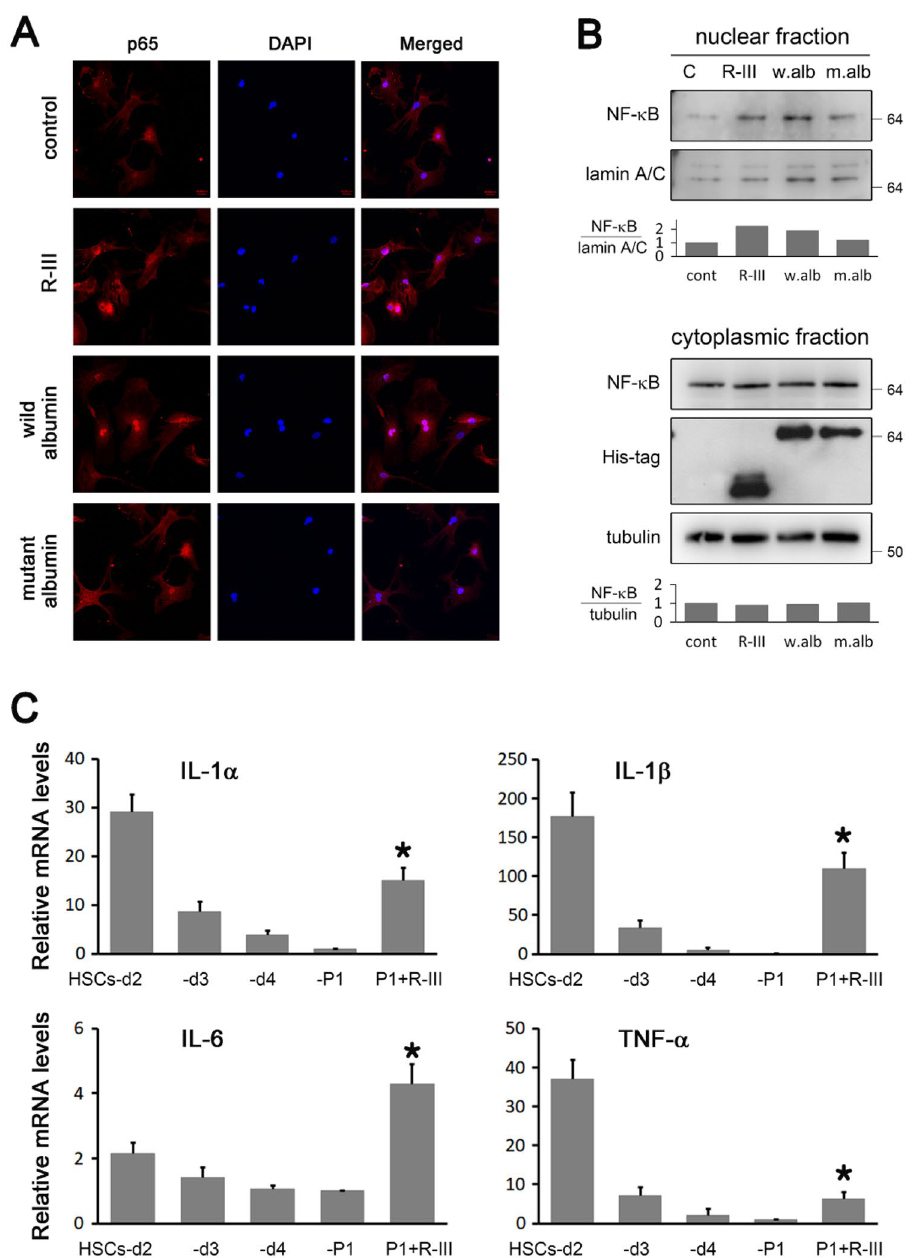
Figure 2. R-III treatment and albumin expression promote the nuclear translocation of NF-κB. ( A , B ) Hepatic stellate cells after passage 1 (HSCs-P1) were treated with HPLC-purified, His-tagged R-III (0.25 μM) or transfected with plasmids encoding His-tagged, wild-type or mutant albumin (R410A, Y411A, K525A) and then analyzed by immunofluorescence using the anti-p65 antibody ( A ). The cell nuclei were stained with DAPI (blue). ( B ) Nuclear and cytoplasmic fractions were prepared from the treated cells and subjected to western blotting using anti-NF-κB antibody. Lamin A/C and α-tubulin were used as internal controls. Bar graph represents the average of two independent experiments. Full-length blots are presented in Supplementary Fig. S4. ( C ) Total RNA was isolated from the HSCs on days 2, 3, and 4 after seeding (different stages of activation), and HSCs-P1 with or without R-III treatment, and the expression levels of IL-1α, IL-1β, IL-6, and TNF-α were then analyzed by real-time PCR. * P < 0.05, paired t -test ( n = 3) (compared with untreated